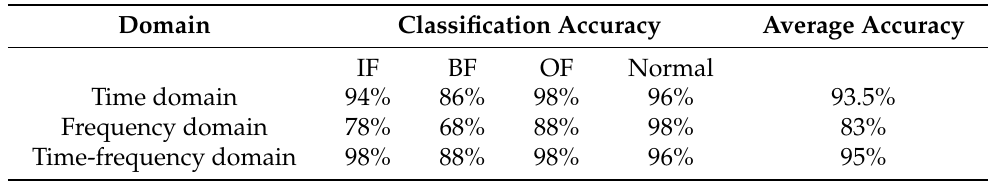
Table 5. Comparison of the classification results by using different